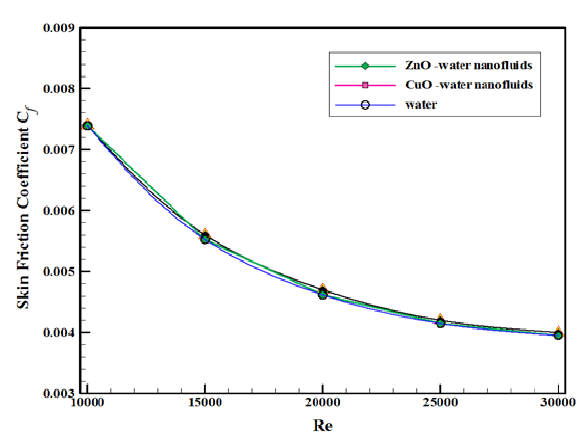
Fig. 8. Skin friction factorvariation of for pure waterand different nanofluids types with trapezoidal